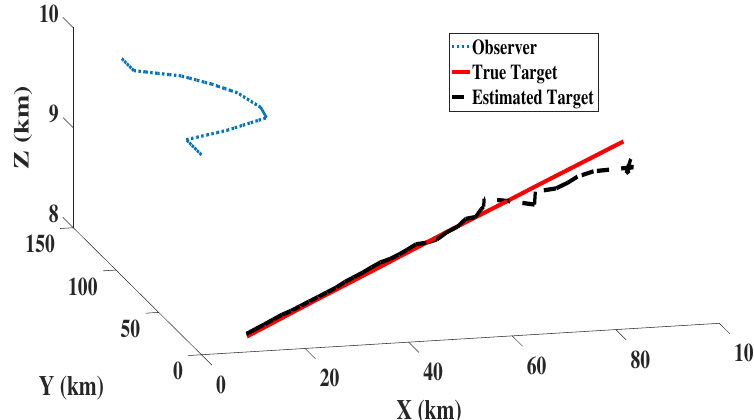
Figure 5. Target truth and estimated path obtained from